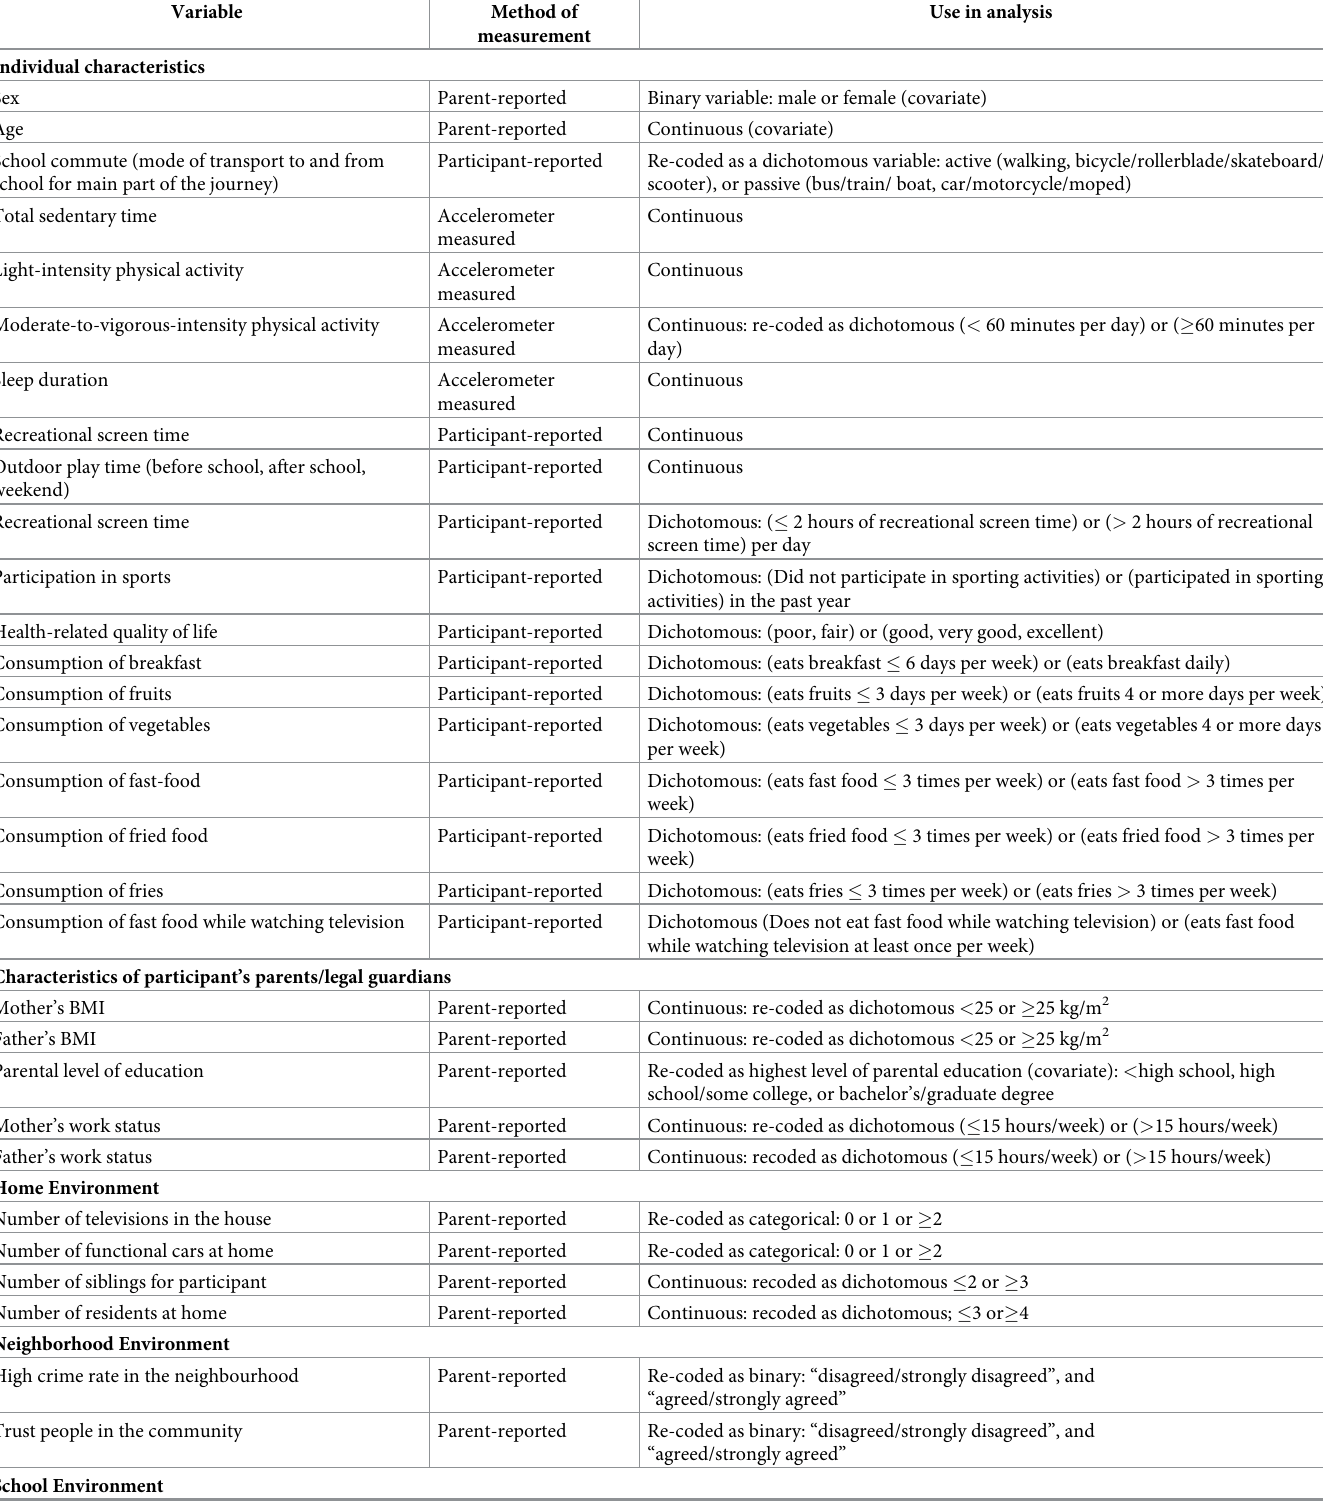
Table 1. Potential correlates of objectively measured thinness or